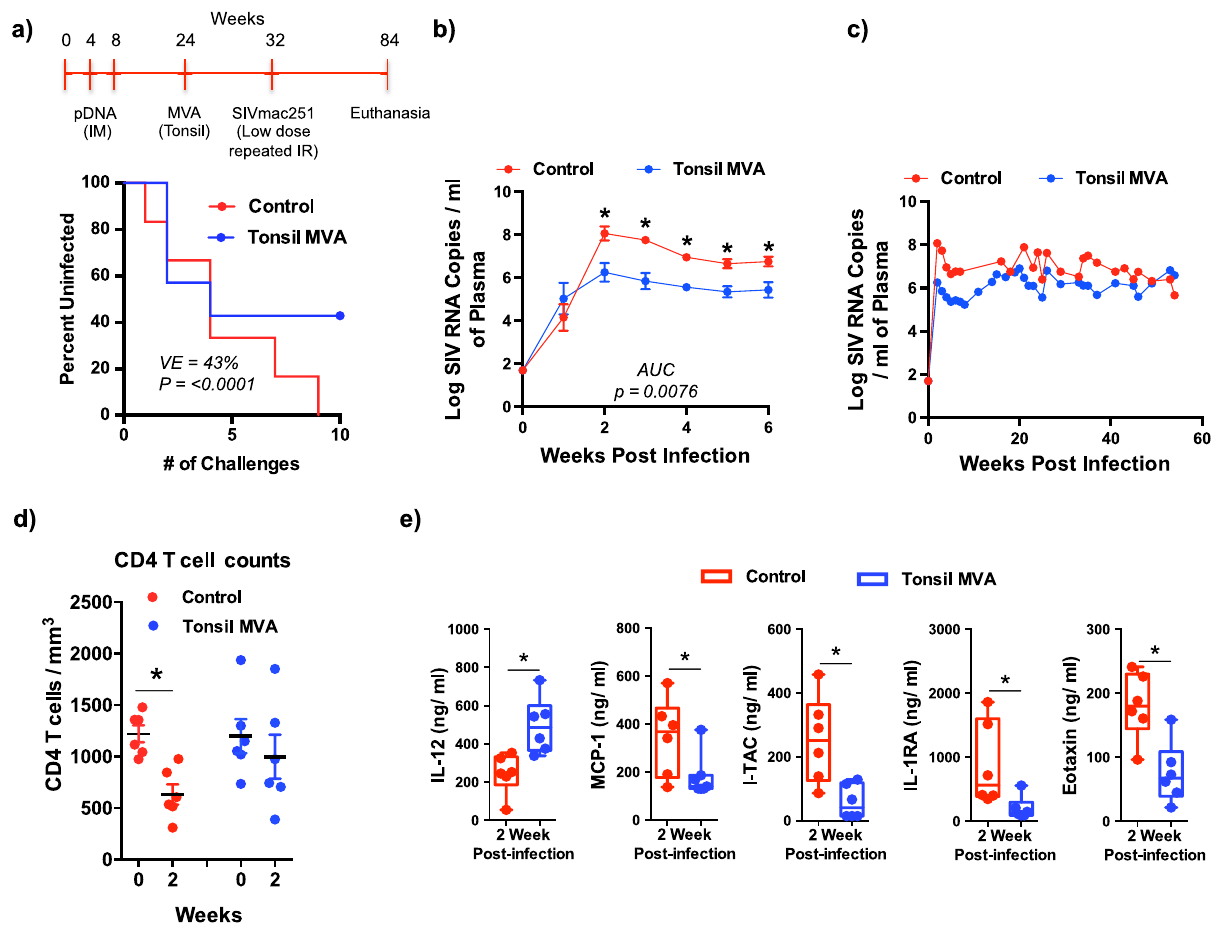
Fig. 2 | Tonsil vaccination with MVA prevents SIVmac251 acquisition and is associated with control of acute viremia. ( a ) Study design and percentage of uninfectedanimalsafterrepeatedlowdoseintrarectalchallengewithSIVmac251in tonsil vaccinated ( n =6) and control ( n =6) groups. Statistical analysis was per- formed using one-tailed Fishers Exact Test as described in ref. 101 and a P <0.05 (*) was considered signi fi cant. Kinetics of plasma viral loads (Limit of detection is 50 copies/ml of plasma) ( b ) during 1 st 6 weeks after infection and ( c ) over a period of 52 weeks in control ( n =6) and tonsil vaccinated ( n =6) animals. Area Under Curve (AUC) was determined using Prism followed by Mann – Whitney U test with error barsrepresentstandarderror.( d )AbsoluteCD4Tcellscountsat0and2weekspost infection is control ( n =6; P =0.0043) and tonsil vaccinated ( n =6; P =ns) animals.